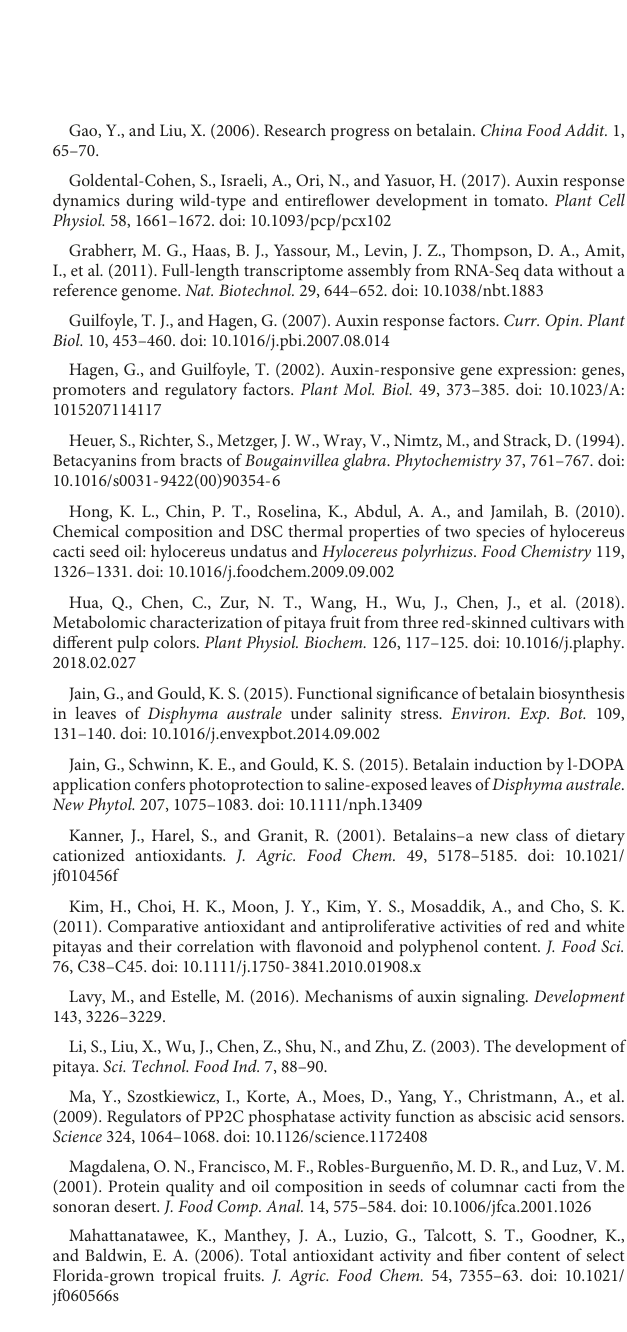
SUPPLEMENTARYFIGURE2 The specific top 20 GO terms for each comparison. SUPPLEMENTARYFIGURE3 KEGG pathway enrichment analysis of DE genes of red fruits during growth. SUPPLEMENTARYFIGURE4 KEGG pathway enrichment analysis of DE genes of white fruits during growth. SUPPLEMENTARYFIGURE5 Significant clustered profiles in peel and pulp of white and red